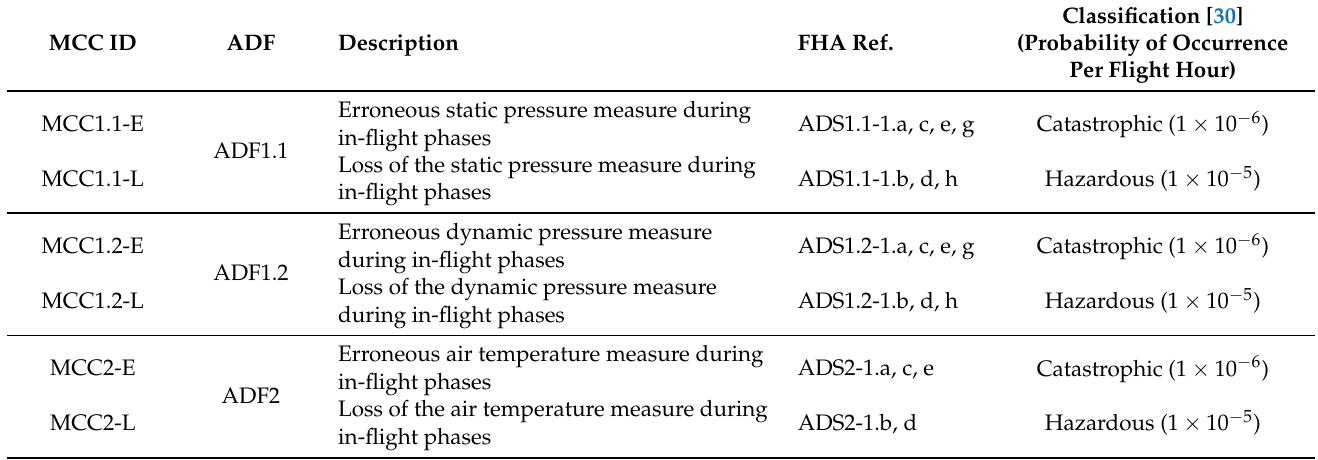
Table 5. ADS most critical conditions (MCCs) for ADF loss or annunciated